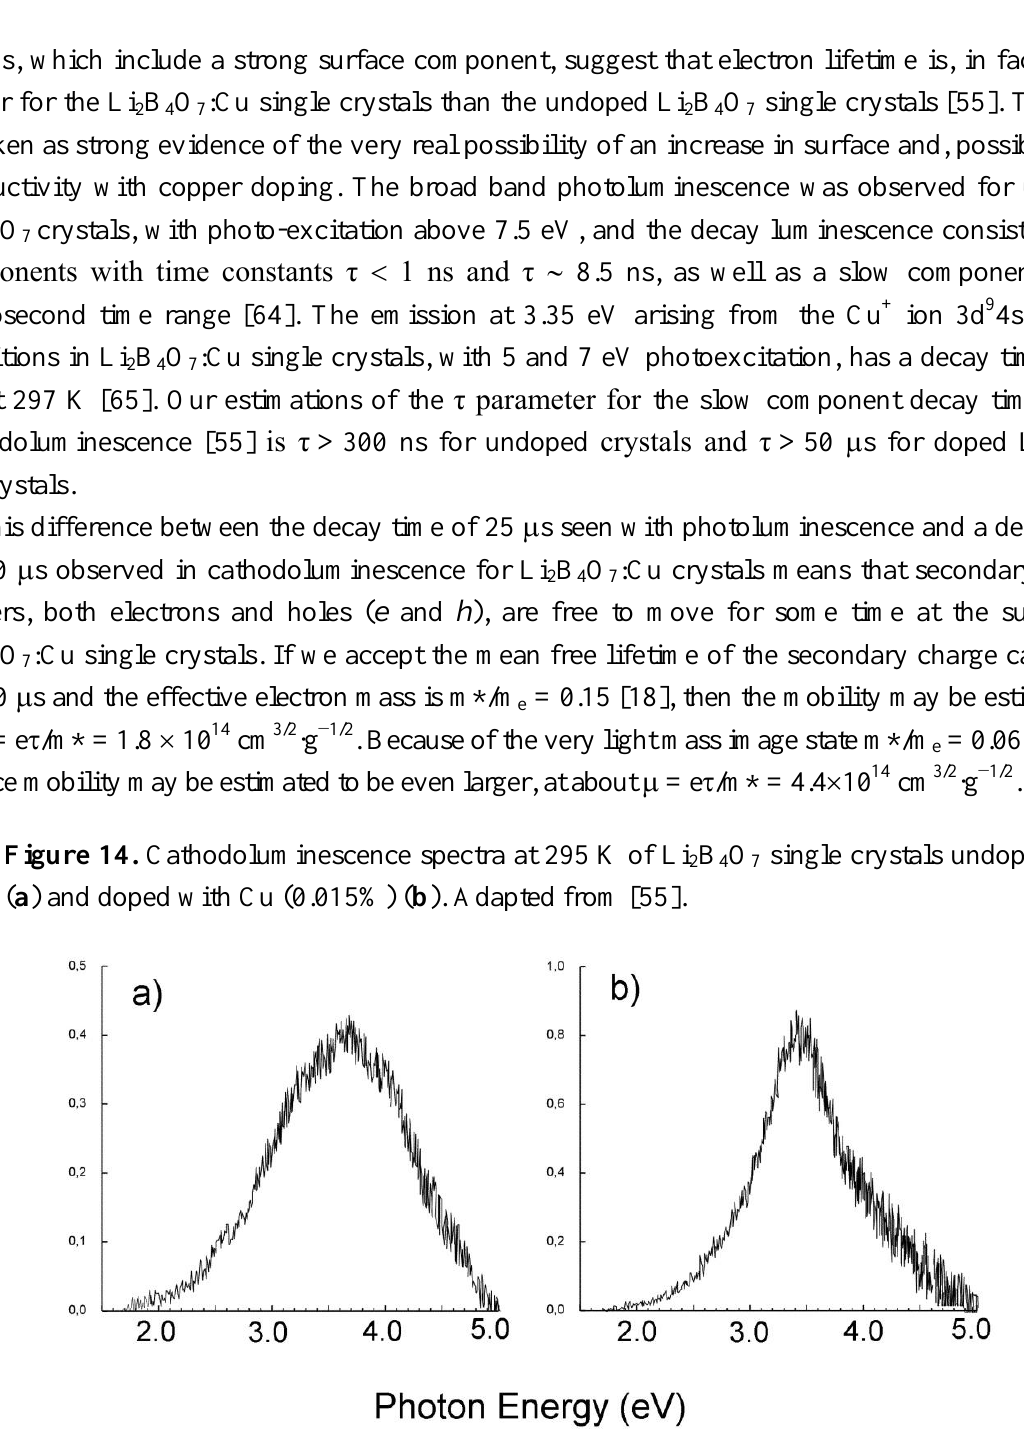
B O single crystals undoped 2 4 7